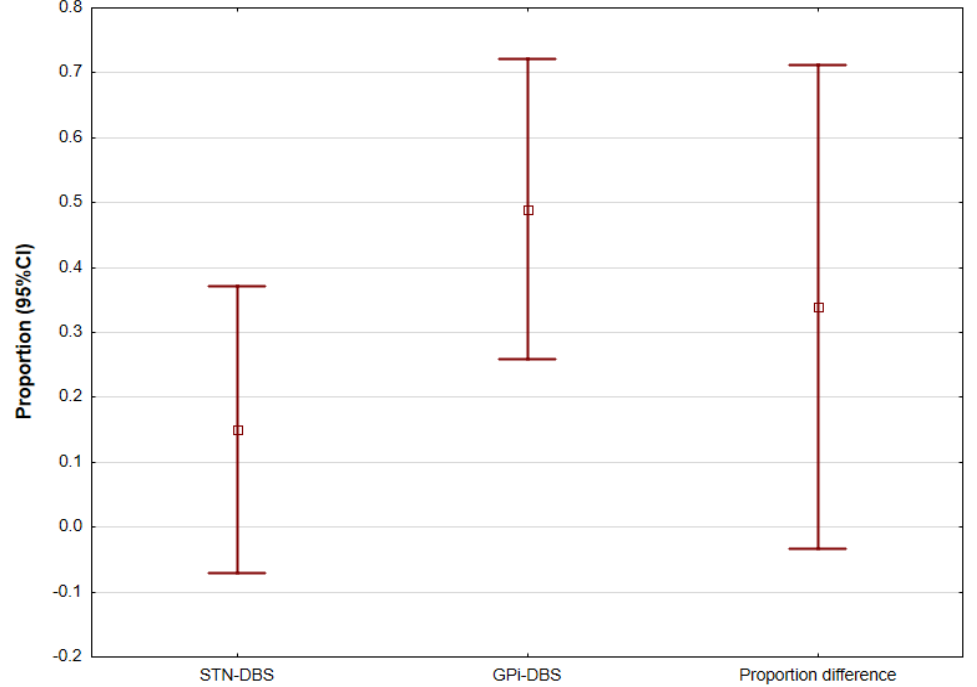
Figure 1. Proportion comparison of AIMS score (initial evaluation to 6-months follow up) between STN DBS and GPi DBS. AIMS—Abnormal Involuntary Movement Scale, DBS—deep brain stimula- tion, GPi—internal globus pallidus, STN—subthalamic nucleus.